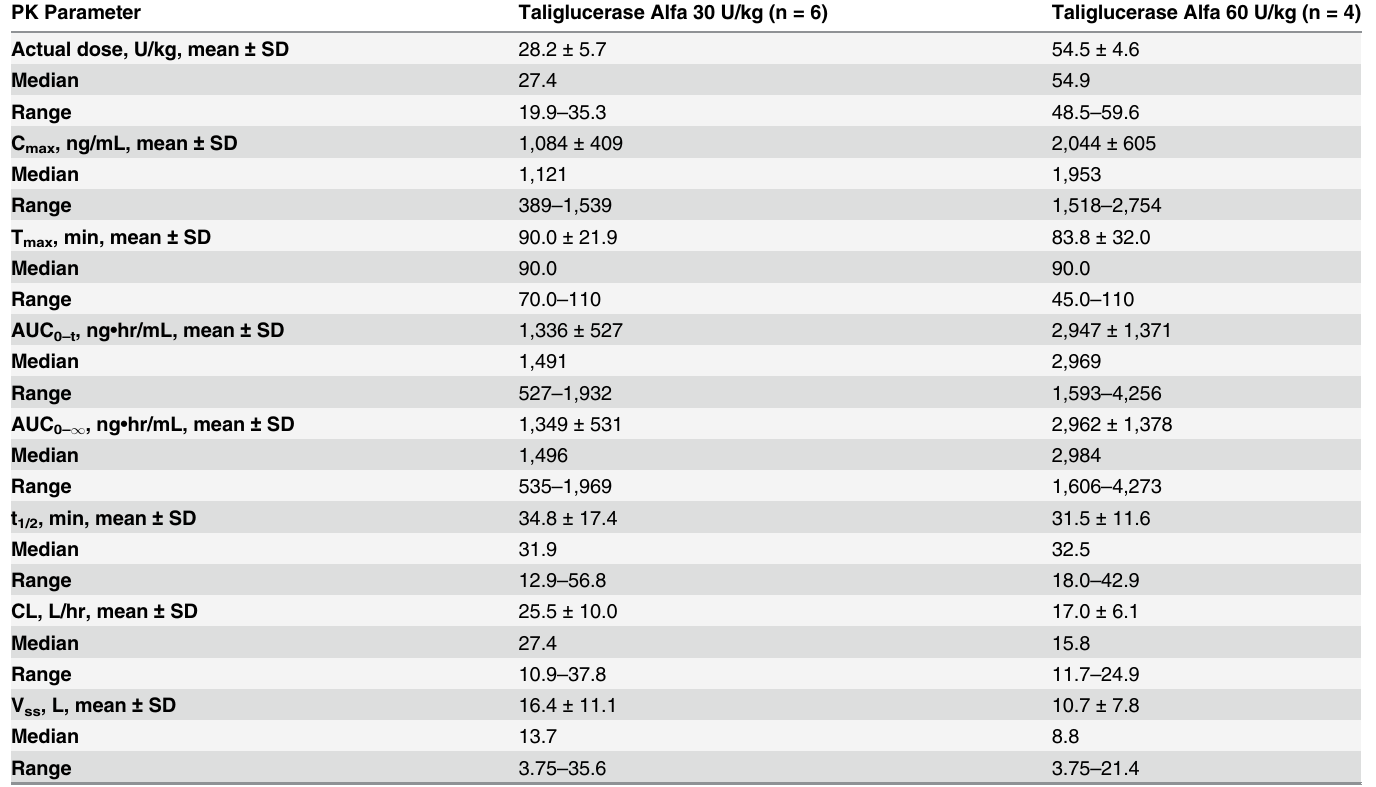
Table 3. Summary of PK parameters of taliglucerase alfa in pediatric patients.